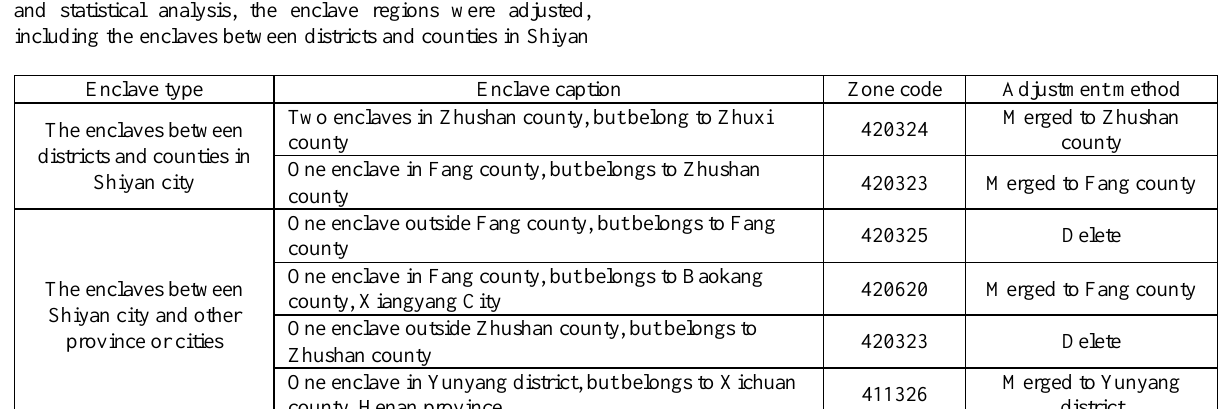
Figure 1. The study area